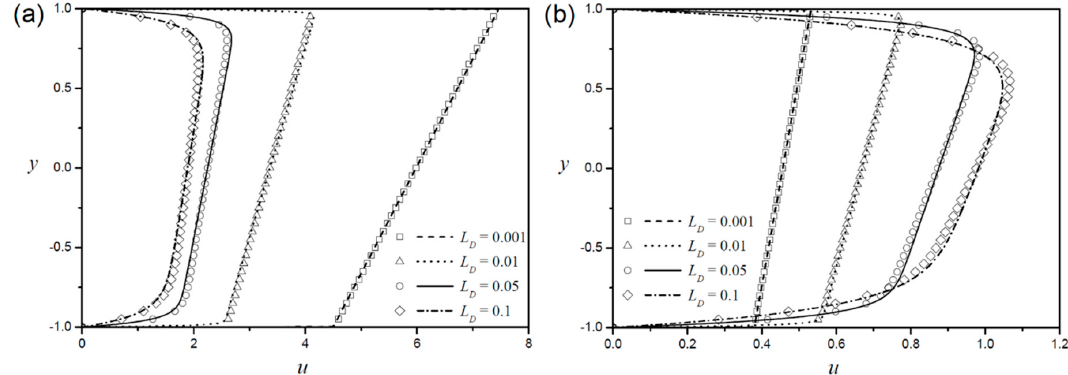
Figure 4. Velocity profiles according to different zeta potential ratios with a fixed Debye length ( L D = 0.05) for ( a ) shear thinning fluid ( n = 0.8 ) and ( b ) shear thickening fluid ( n = 1.2 ).